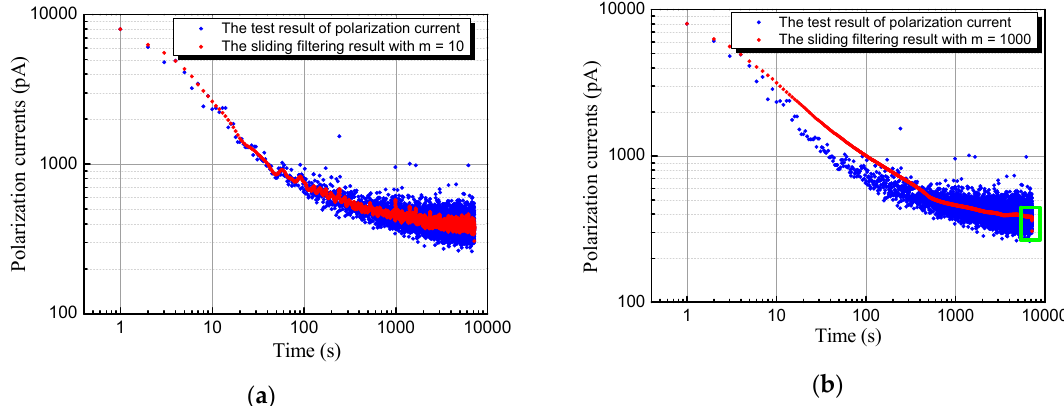
Figure 4. The effect diagram of moving average filtering with different adjacent numbers: ( a ) the Figure 4. The e ff ect diagram of moving average filtering with di ff erent adjacent numbers: ( a ) the filtering results with m = 10; and ( b ) the filtering results with m = 1000. filtering results with m = 10; and ( b ) the filtering results with m =